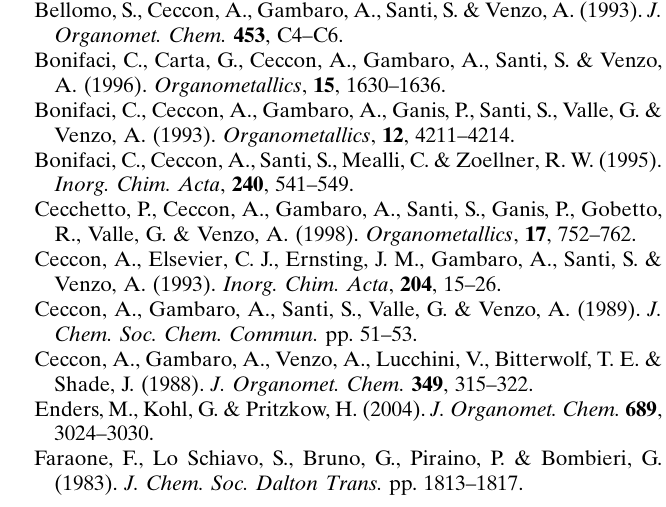
H Cr O Rh , 29 18 2 9 2